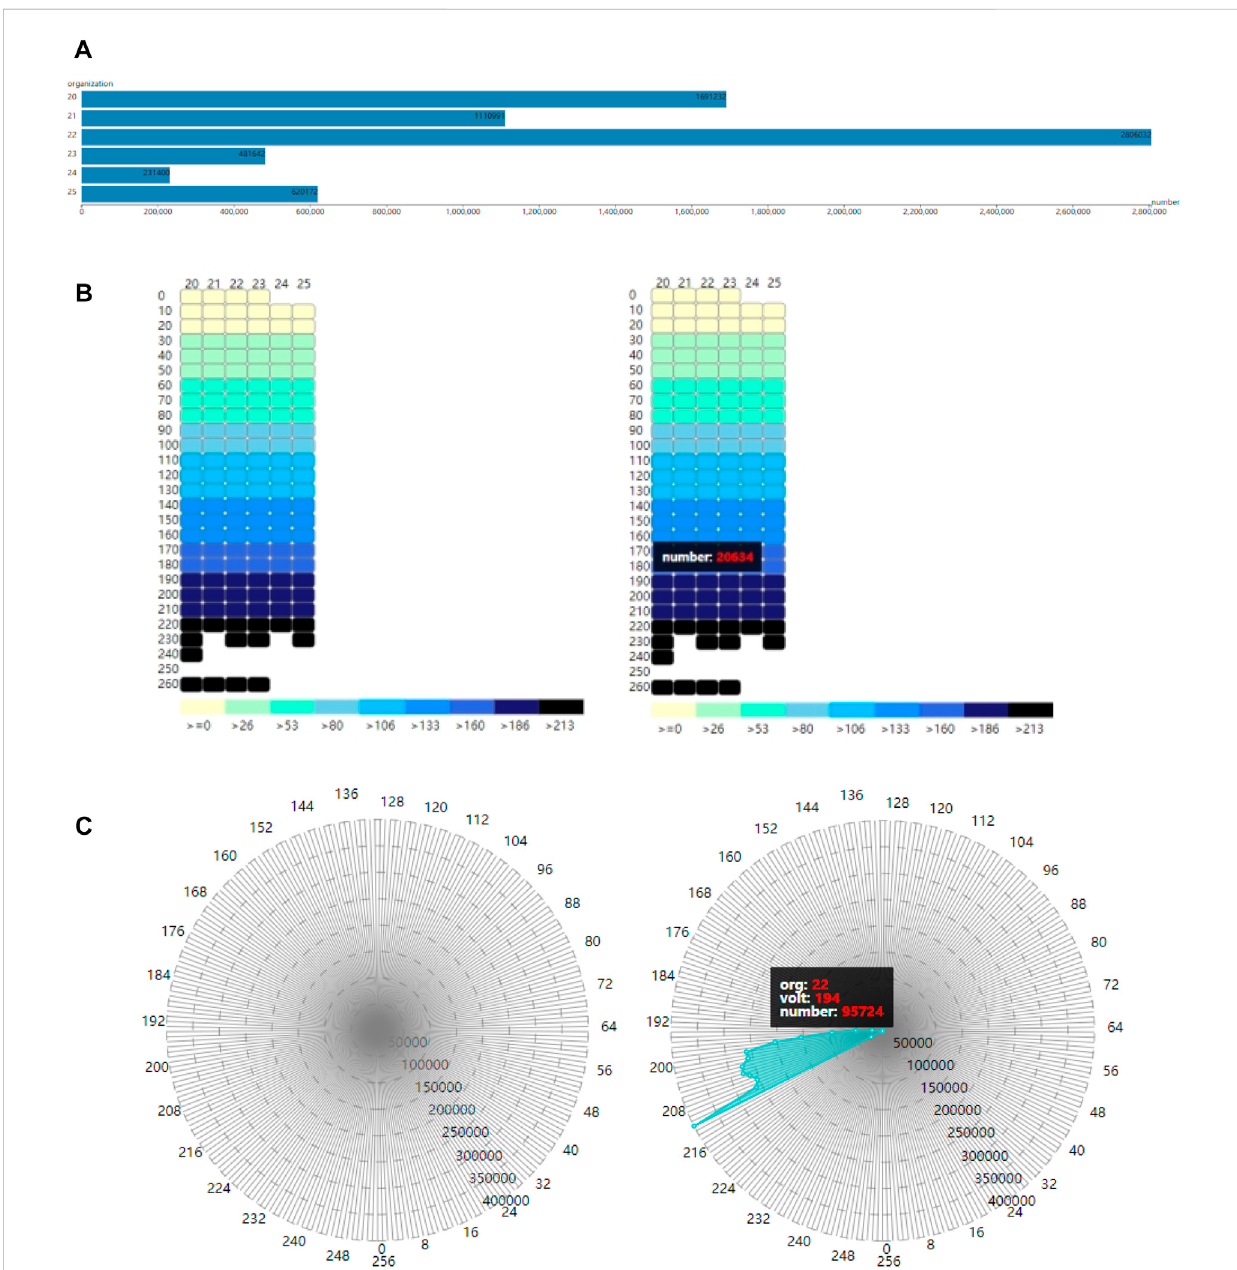
FIGURE 4 Three modules for cardiac physical and physiological modals (A) . Tissue-myocyte module (B) . Tissue-electrophysiology module (C) . Electrophysiology-myocyte